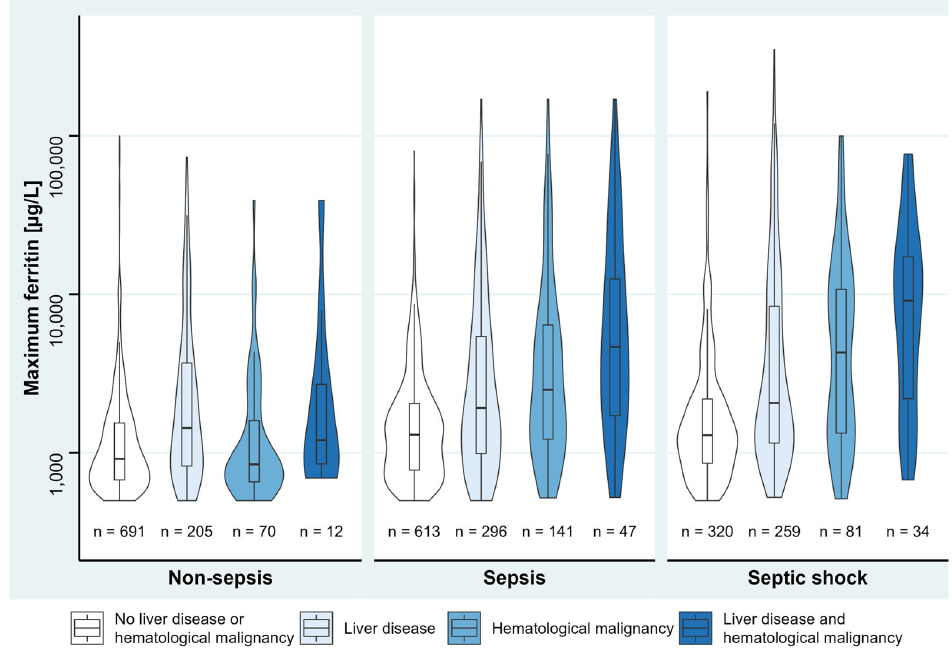
Figure 3. Ferritin levels of sepsis groups stratified by the presence of liver disease and hematological malignancy. Violin plots show data distribution and enclosed boxplots show median with quartiles (25–75%). Whiskers below and above show minimum and maximum values, respectively. For improved visualization, y -axis is plotted in logarithmic scale. Due to various numbers of ICD-10 codes in each single patient, patients partially overlap between the disease